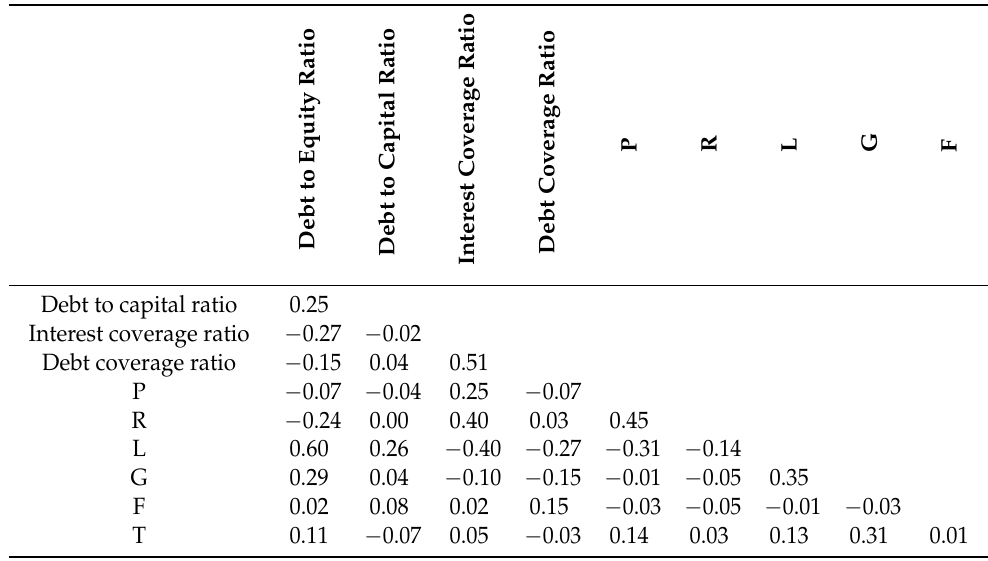
Table A2. Correlation matrix of additional indicators,